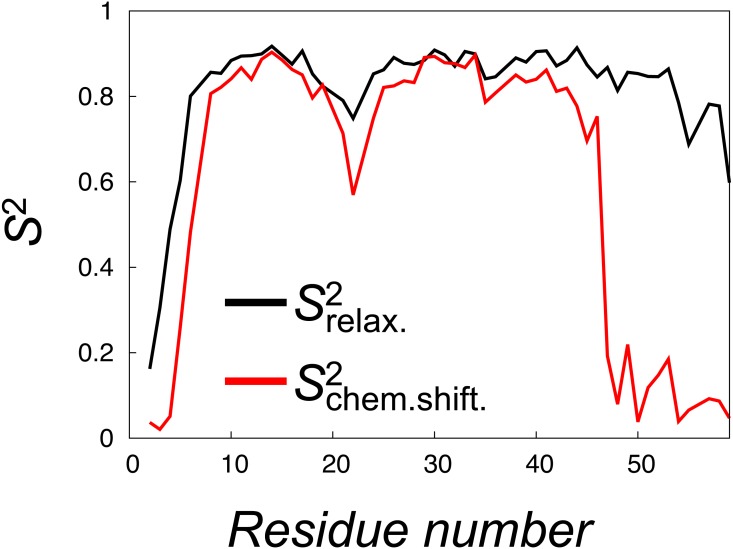
Calculation of order parameters from MD simulations to probe short and long timescale dynamics.We calculated S2 order parameters that reflect either motions faster than overall tumbling of the protein (black) or longer timescale motions that give rise to chemical shift and NOE averaging (red). For reference, the main chain Root Mean Square Deviation (RMSD) values of the 28 unbiased simulations that we used to calculate the \documentclass[12pt]{minimal}
\usepackage{amsmath}
\usepackage{wasysym}
\usepackage{amsfonts}
\usepackage{amssymb}
\usepackage{amsbsy}
\usepackage{upgreek}
\usepackage{mathrsfs}
\setlength{\oddsidemargin}{-69pt}
\begin{document}
}{}${S}_{\text{relaxation}}^{2}$\end{document}Srelaxation2 values are shown in Fig. S3.